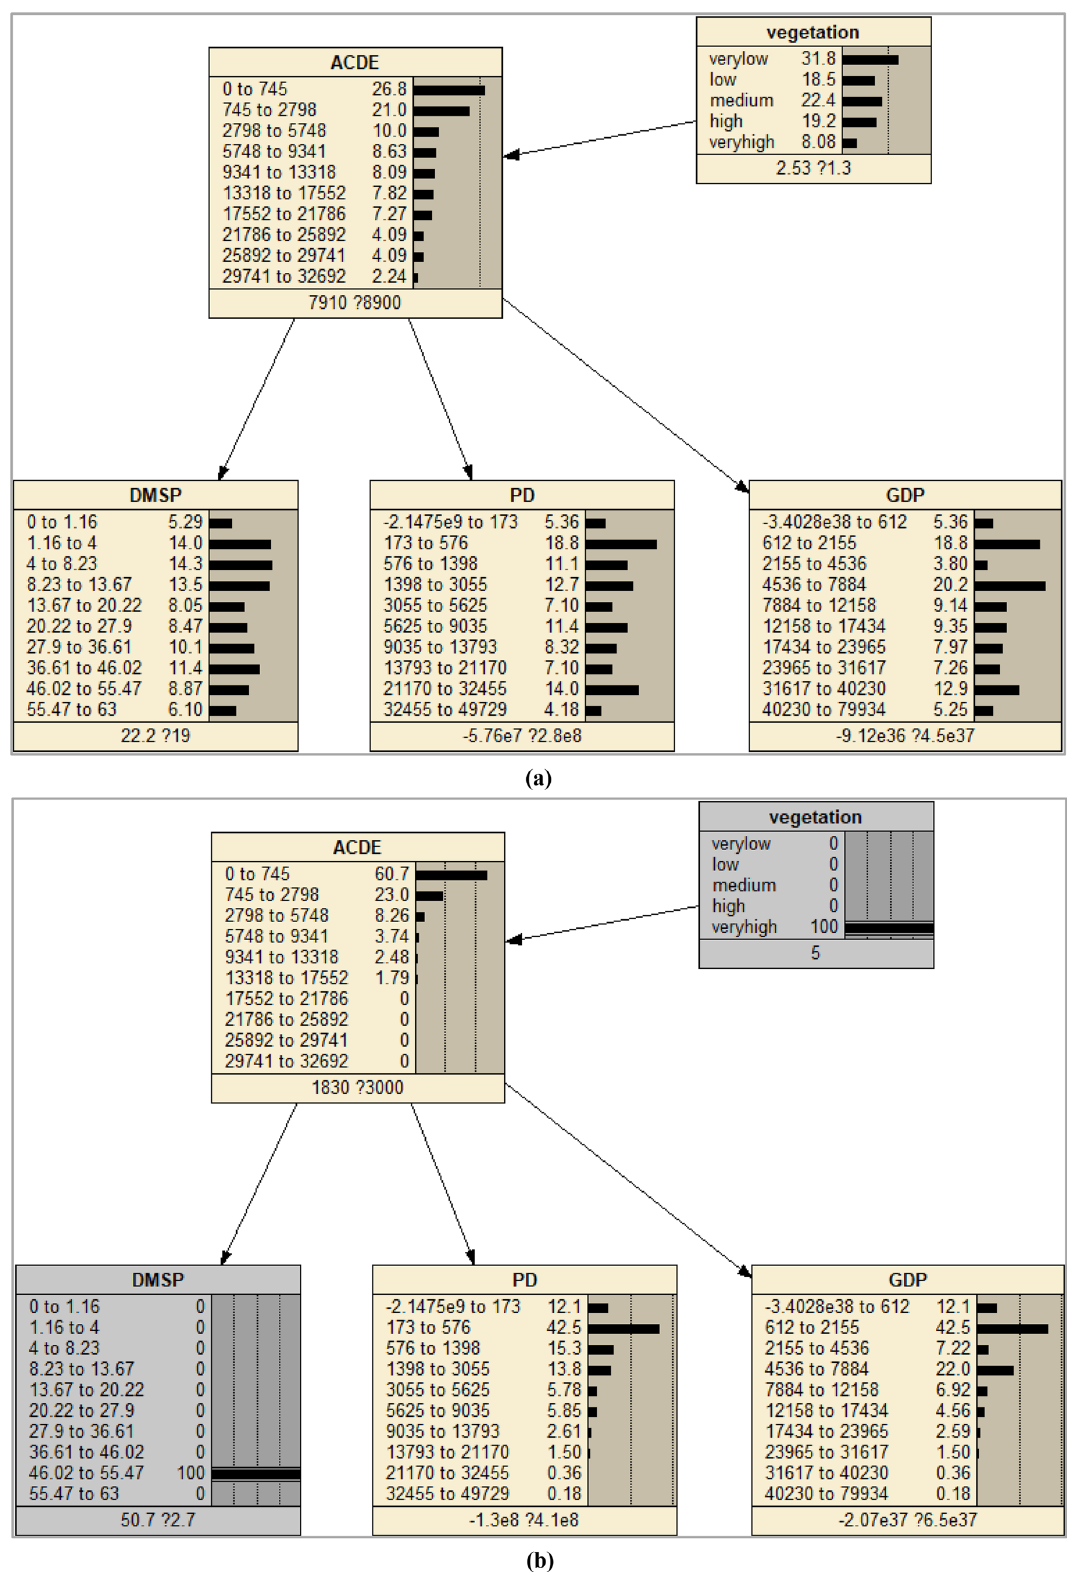
Figure 13. Naïve Bayesian Network fusing vegetation data as prior knowledge. ( a ) CPTs when adding a vegetation node as the prior knowledge, ( b ) CPTs when give an evidence of vegetation. The figs were generated using the Netica software (Norsys Software Corp, Version 5.02, https:// www. norsys.